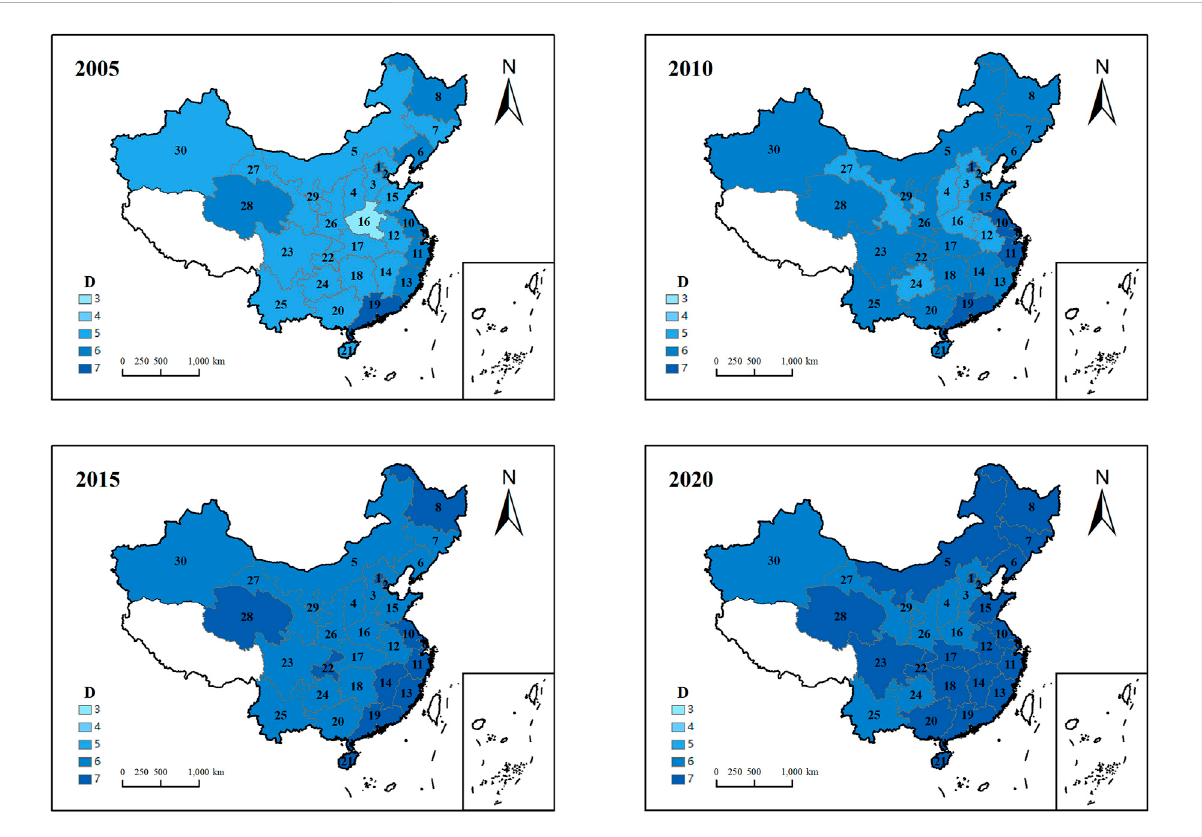
FIGURE 6 Spatial evolution of coupling coordination level between HQD and RECC of 30